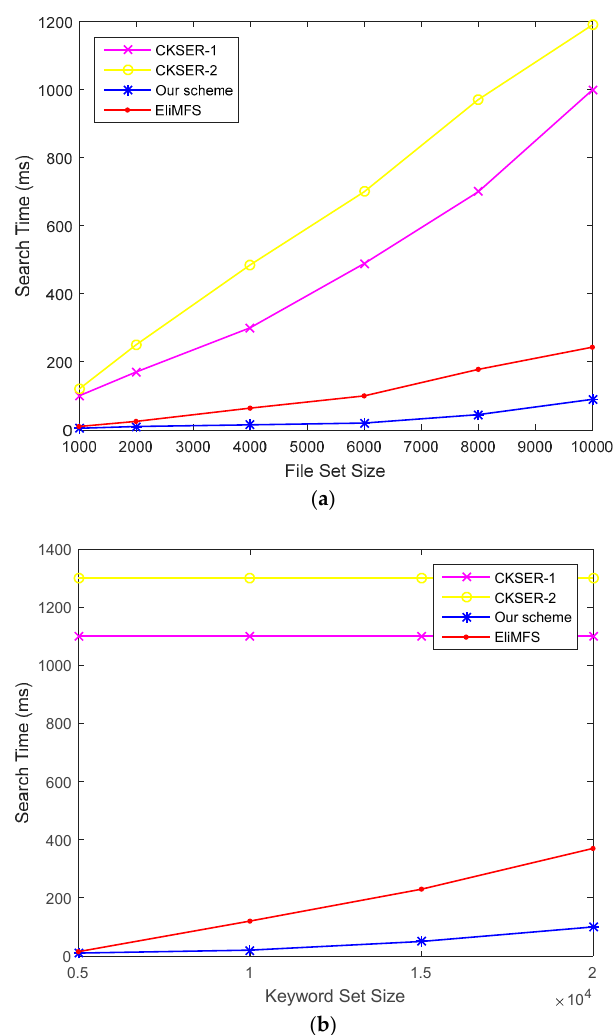
Figure 11. Time consumption of search process. ( a ) Time consumption of search process changes with the size of file set ( n = 8000); ( b ) Time consumption of search process changes with the size of file set ( n = 8000).